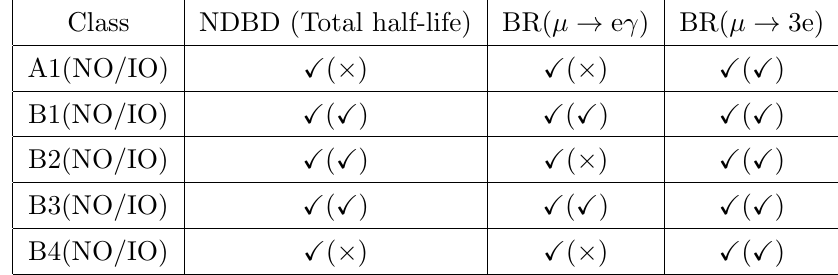
Table 5 . Summary of allowed and disallowed textures. The X and (cid:2) symbol are used to denote if the observables (NDBD/CLFV) are (not are) within the current experimental upper limit.